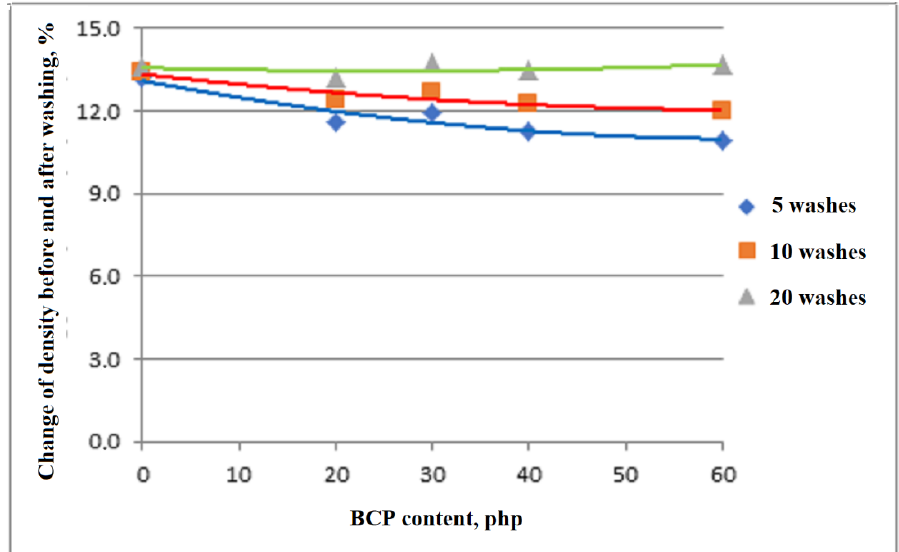
Figure 16. Change in foam apparent density after washing.